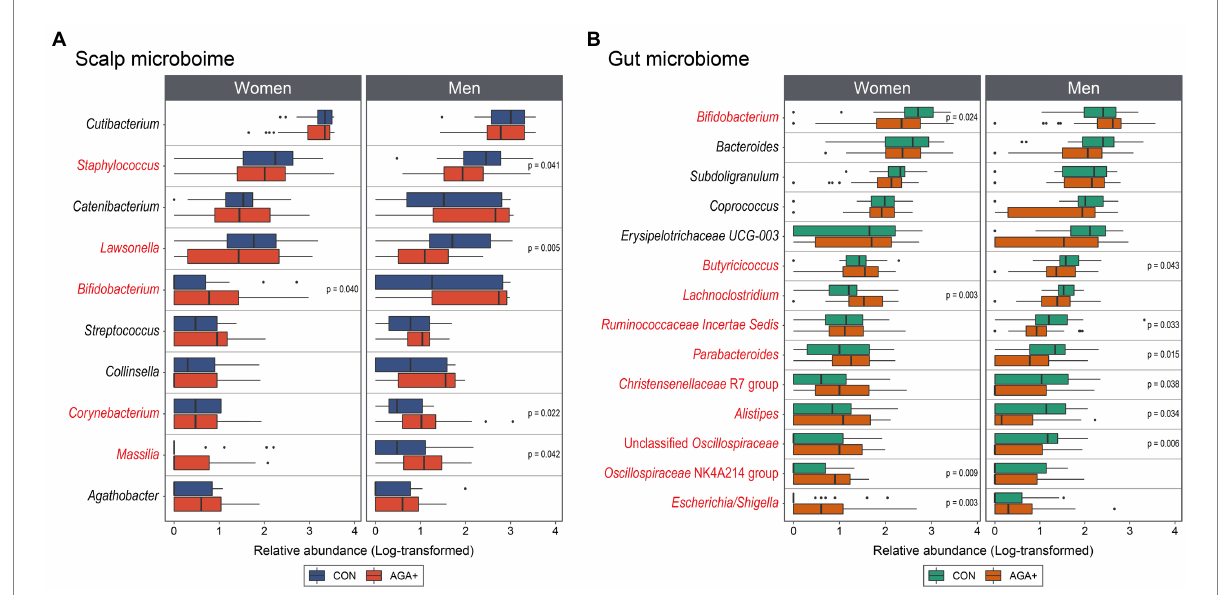
FIGURE 4 Differential abundance analysis of scalp (A) and gut (B) microbiome between healthy controls (CON) and individuals with AGA (AGA+) at the genus level. Boxplots represent log-transformed abundances of individual genera. Taxa with p < 0.05 or 0.01 determined using the Wilcoxon rank-sum test are indicated with asterisks (* and **, respectively). The genera marked in red are significantly different (CON vs. AGA+) in at least one women or men